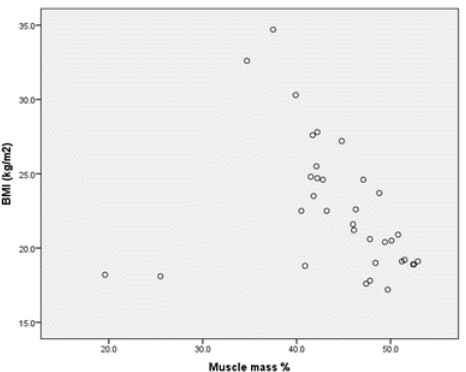
Figure 4. Correlation between BMI and muscle and mass % for the group of boys MID.